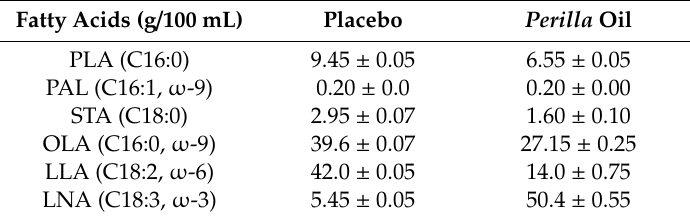
Table 1. Basic fatty acid composition of placebo and perilla